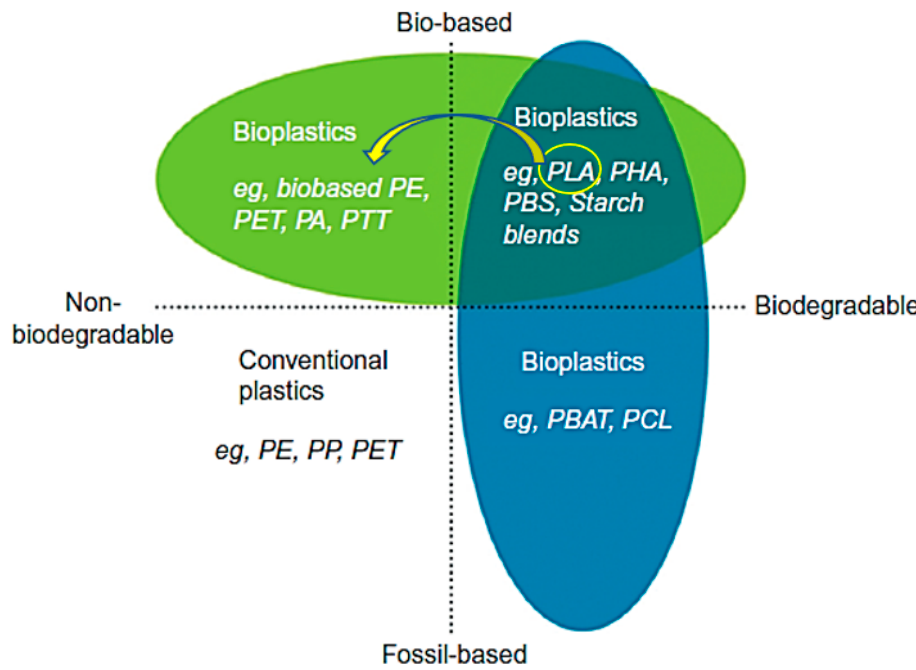
Figure 2. Bioplastics material coordinate system. Adapted from [51].